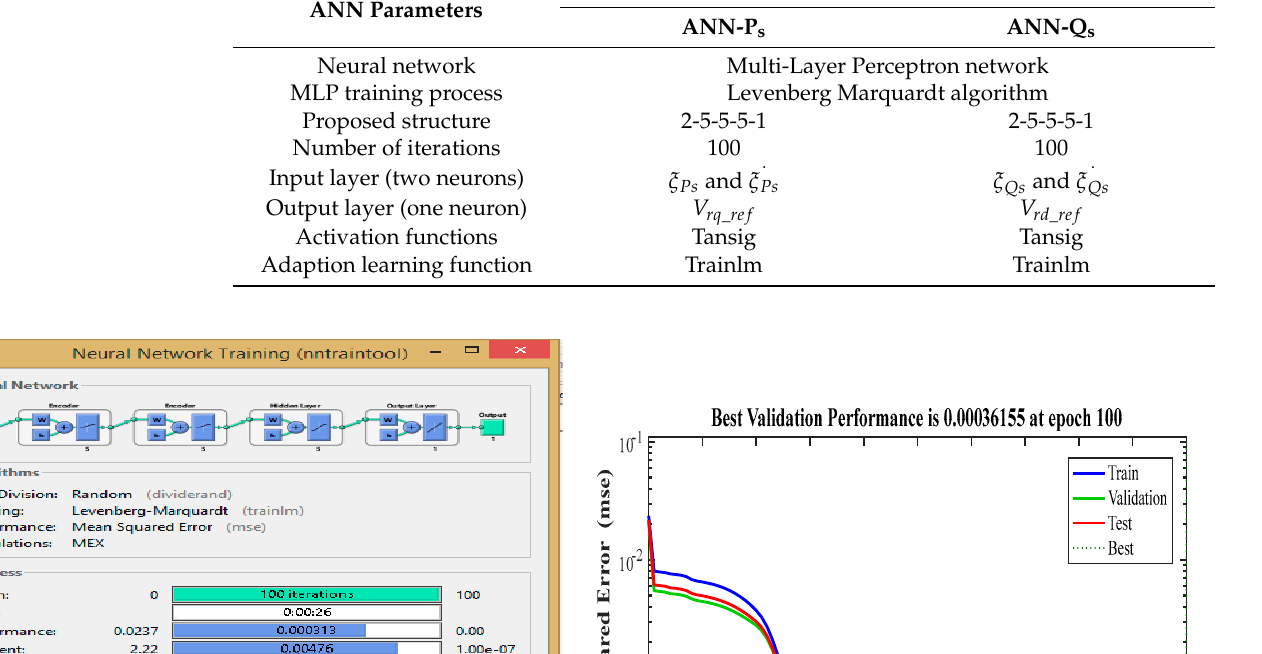
Figure 8. Internal architectural schemes of the MLPs used.